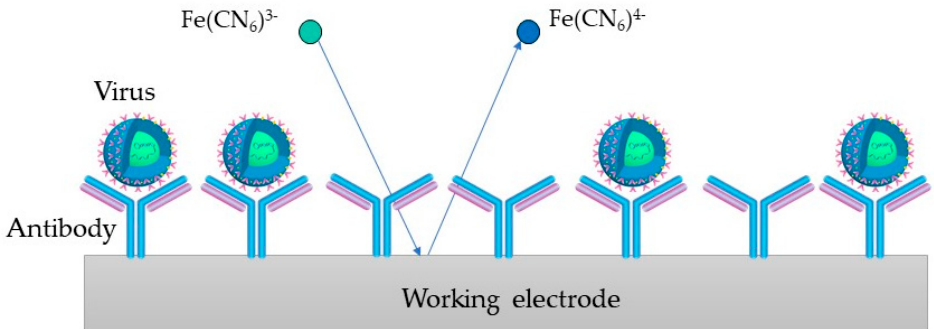
Figure 5. Immunosesor principle, where the virus binds to the antibody at the WE surface and the redox reaction gets hindered.